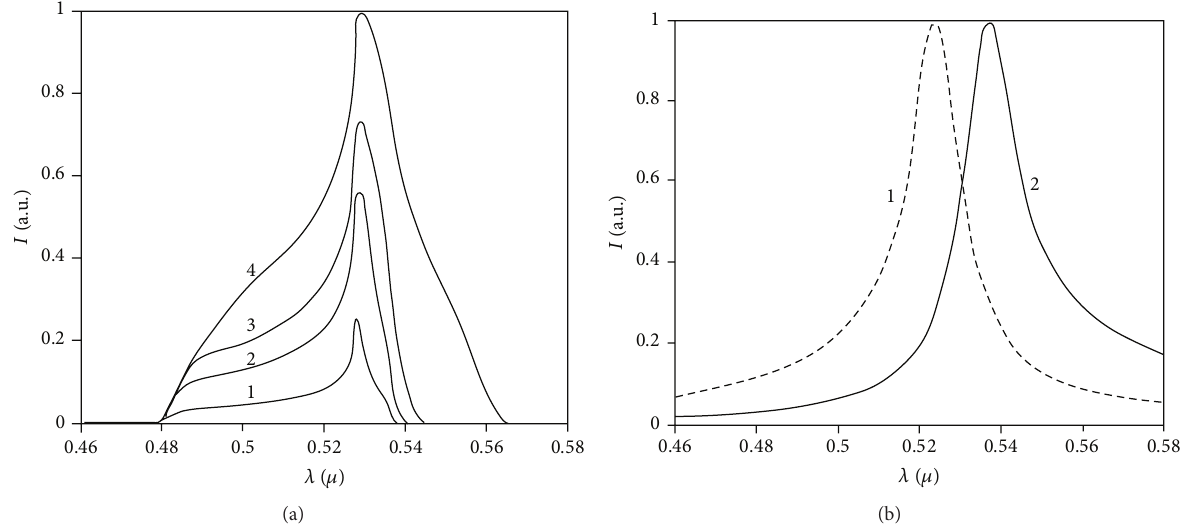
Figure 1: Calculated spectra of converted broadband radiation calculated for LN: (a) type of phase matching, oo-e; angle of convergence of input beam 2𝛼 : 1–1.2 ∘ ; 2–3.4 ∘ ; 3–7.6 ∘ ; 4–10 ∘ and (b) type of phase matching oe-e : 1− o ( 𝜆 1 ) e ( 𝜆 2 )- e ( 𝜆 3 ); 2− o ( 𝜆 2 ) e ( 𝜆 1 )– e ( 𝜆 3 ); 𝜆 1 > 𝜆 2 .